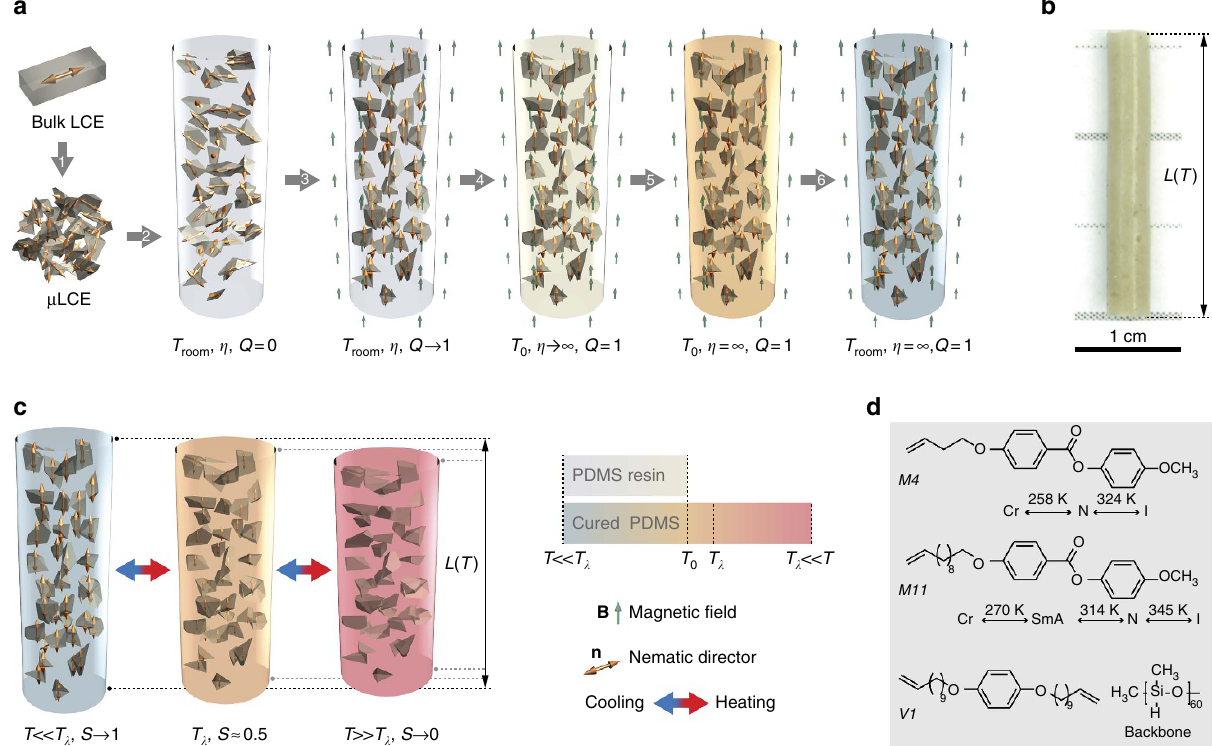
Figure 1 | Preparation of a PDLCE composite. ( a ) Schematic illustration of the six-step PDLCE manufacturing method: (1) crushing the starting bulk LCE into m LCE particles, (2) dispersing the particles in uncured (low viscosity Z ) PDMS elastomer, (3) aligning the initially disordered m LCE in external magnetic field, that is, increasing m LCE orientational order from Q ¼ 0 to Q ¼ 1, (4) heating to setting temperature T 0 , (5) thermal curing of PDMS matrix at T 0 , and (6) cooling the resulting PDLCE composite to T room . ( b ) Photograph of a representative, cylindrically shaped PDLCE-A specimen, prepared according to the method shown in a (see Methods for composition and fabrication details). ( c ) Spontaneous mechanical deformation of PDLCE composite on crossing the nominal thermomechanical anomaly temperature T l of m LCE filler, associated with the change in the nematic order parameter S . Also shown is the colour bar used to colour-code the temperature of PDMS matrix in panels a and c . ( d ) Chemical structure of LCE material constituents: nematic M4 and smectic A M11 mesogenic side-chains with their respective bulk phase transition temperatures between the isotropic (I), nematic (N), smectic A (SmA) and crystalline solid (Cr) states, bi-functional crosslinker V1 , and (poly)methylsiloxane backbone. For animated version of the m LCE alignment procedure ( a ) and of thermomechanical actuation ( c ) play the Supplementary Movie